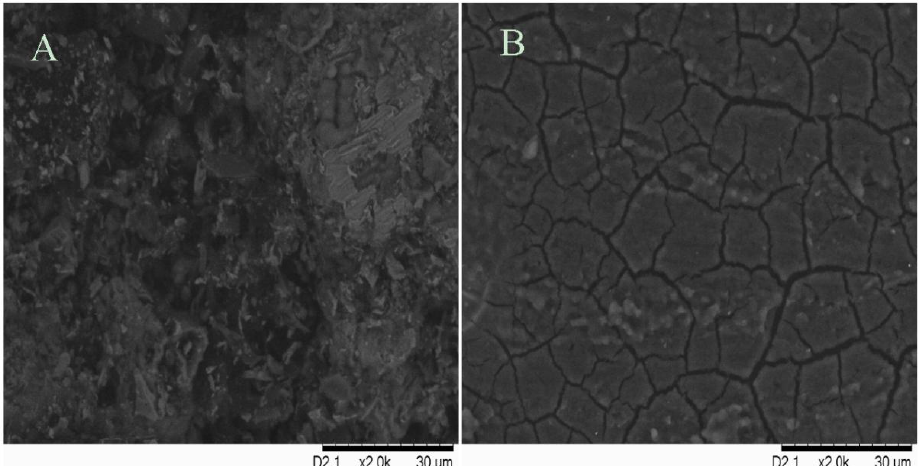
Figure 8. SEM micrographs of mild steel in 1.0 M HCl solution at 30 °C in the absence ( A ) and presence ( B ) of 0.5 mM